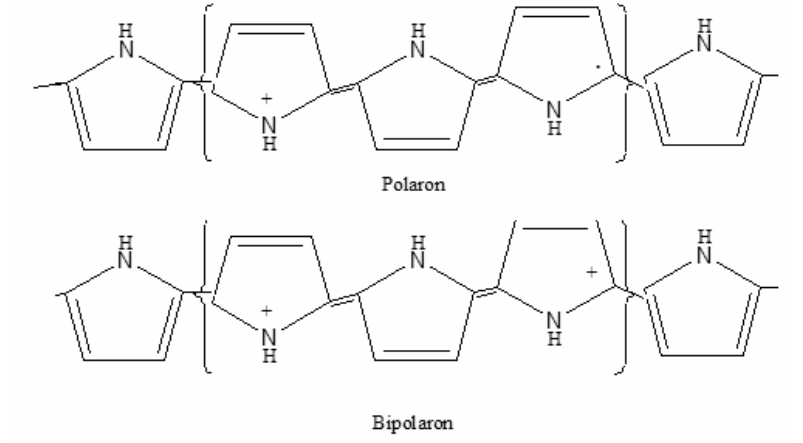
Figure 4. Proposed structures for polarons and